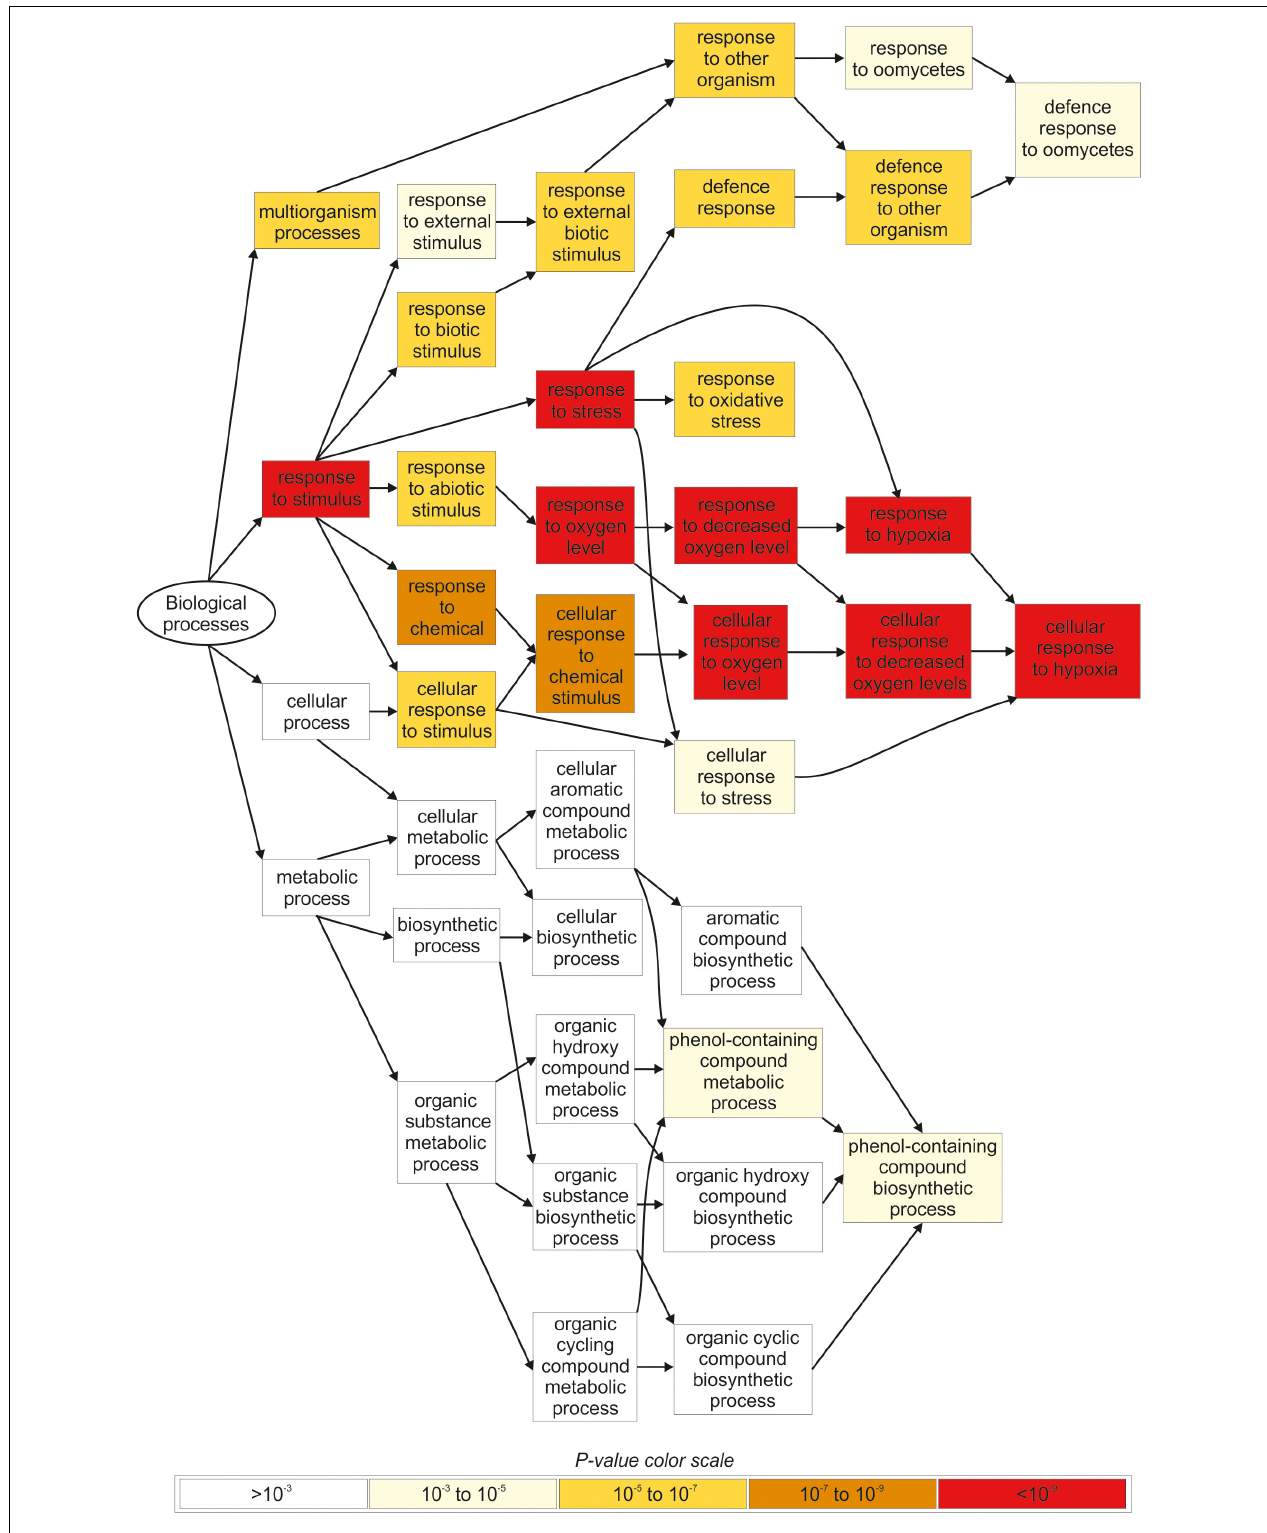
FIGURE 4 | Overview of the main biological processes affected by iodine based on the GO terms enrichment analysis carried out in root tissues. Only genes regulated in NaI- and KI-treated plants, and not in KBr-treated plants, when compared with the control, were analysed. The figure was extracted from GOrilla (http://cbl-gorilla.cs.technion.ac.il) and reproduced. In this analysis, DEGs with log 2 FC ≥ 2.5 or log 2 FC ≤ –2.5 were used.